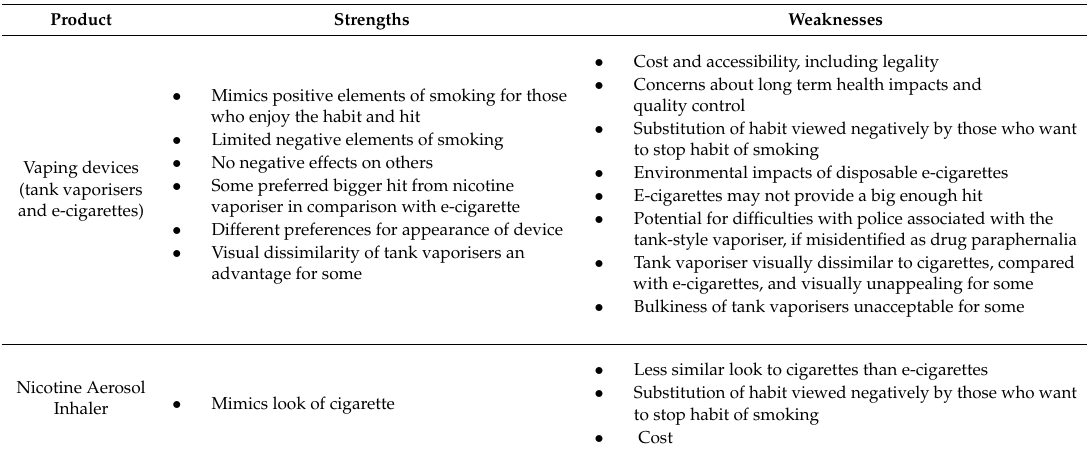
Table 2. Consumer reported views on nicotine